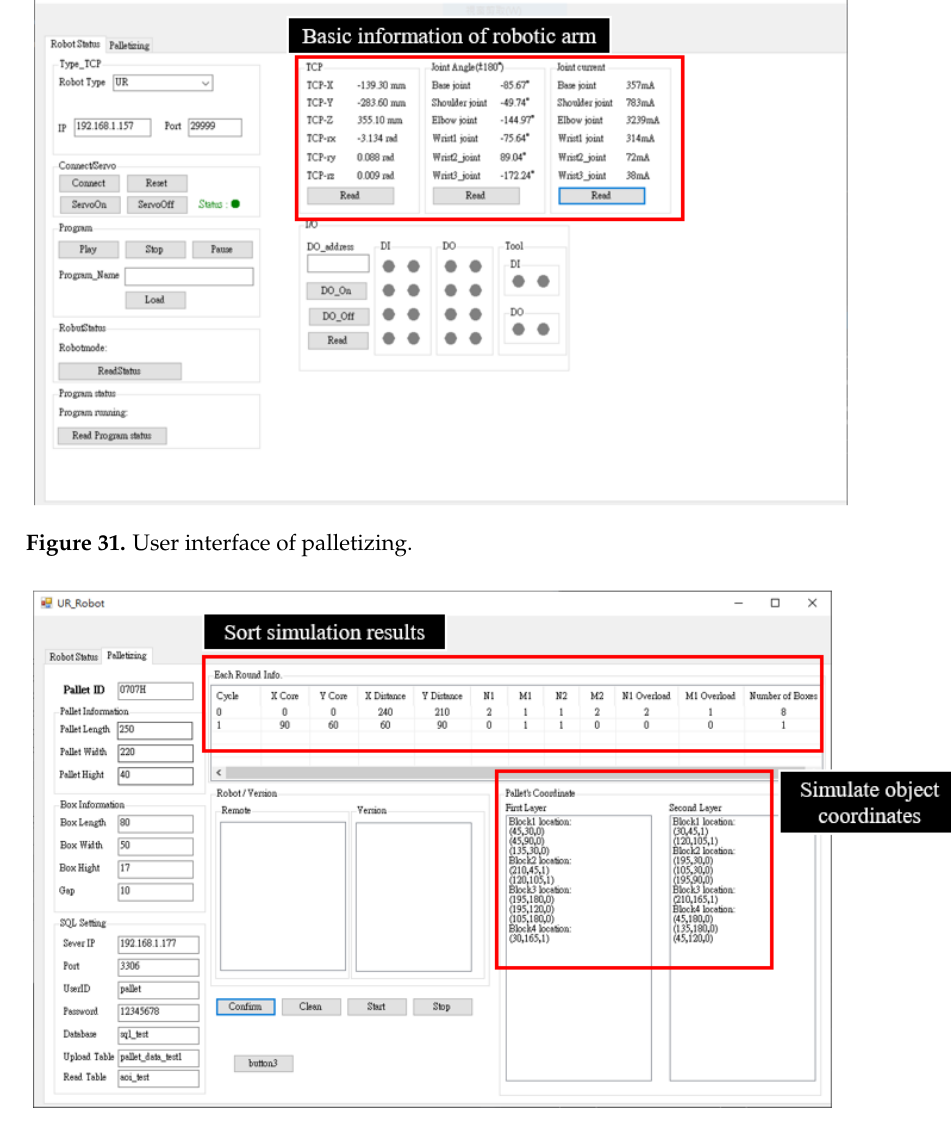
Figure 32. Simulation results.